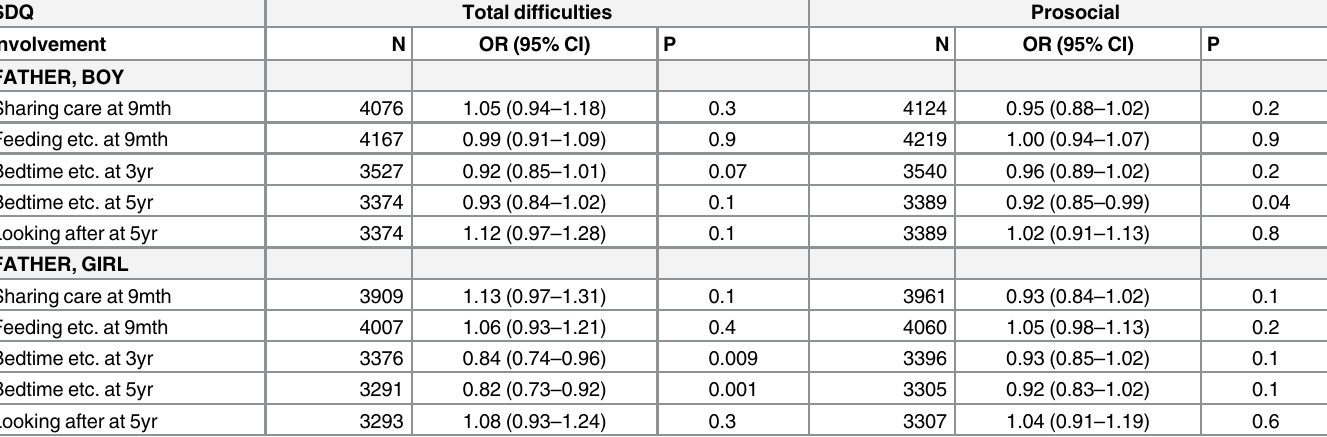
Table 5. Crude odds ratio for child behaviour problems per quintile a of involvement: father-only measures.